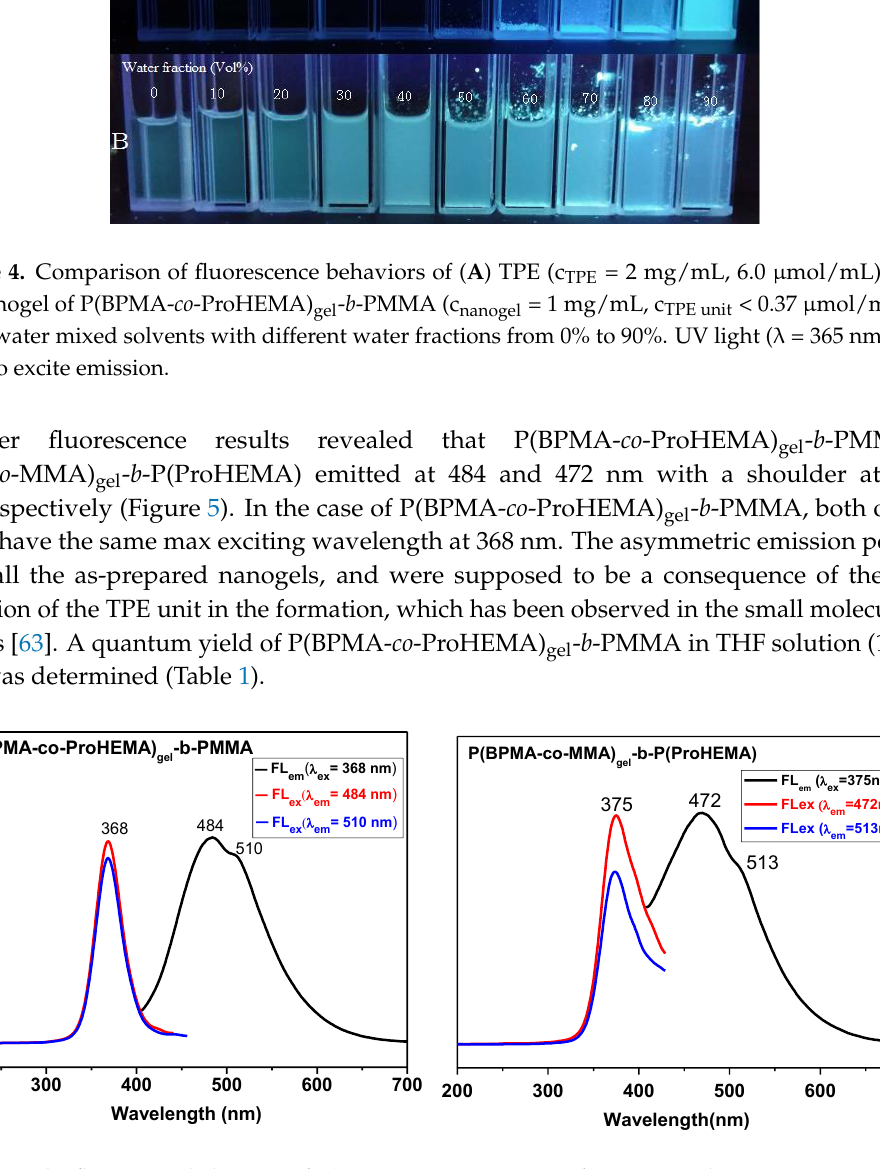
Figure 5. The fluorescent behaviors of P(BPMA- co -ProHEMA) gel - b -PMMA and P(BPMA- co -MMA) gel - b -P(ProHEMA).